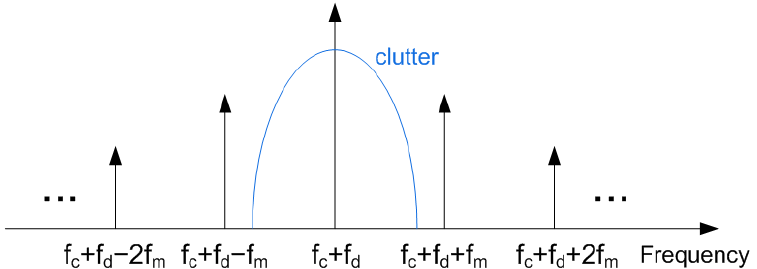
Figure 8. Backscattered